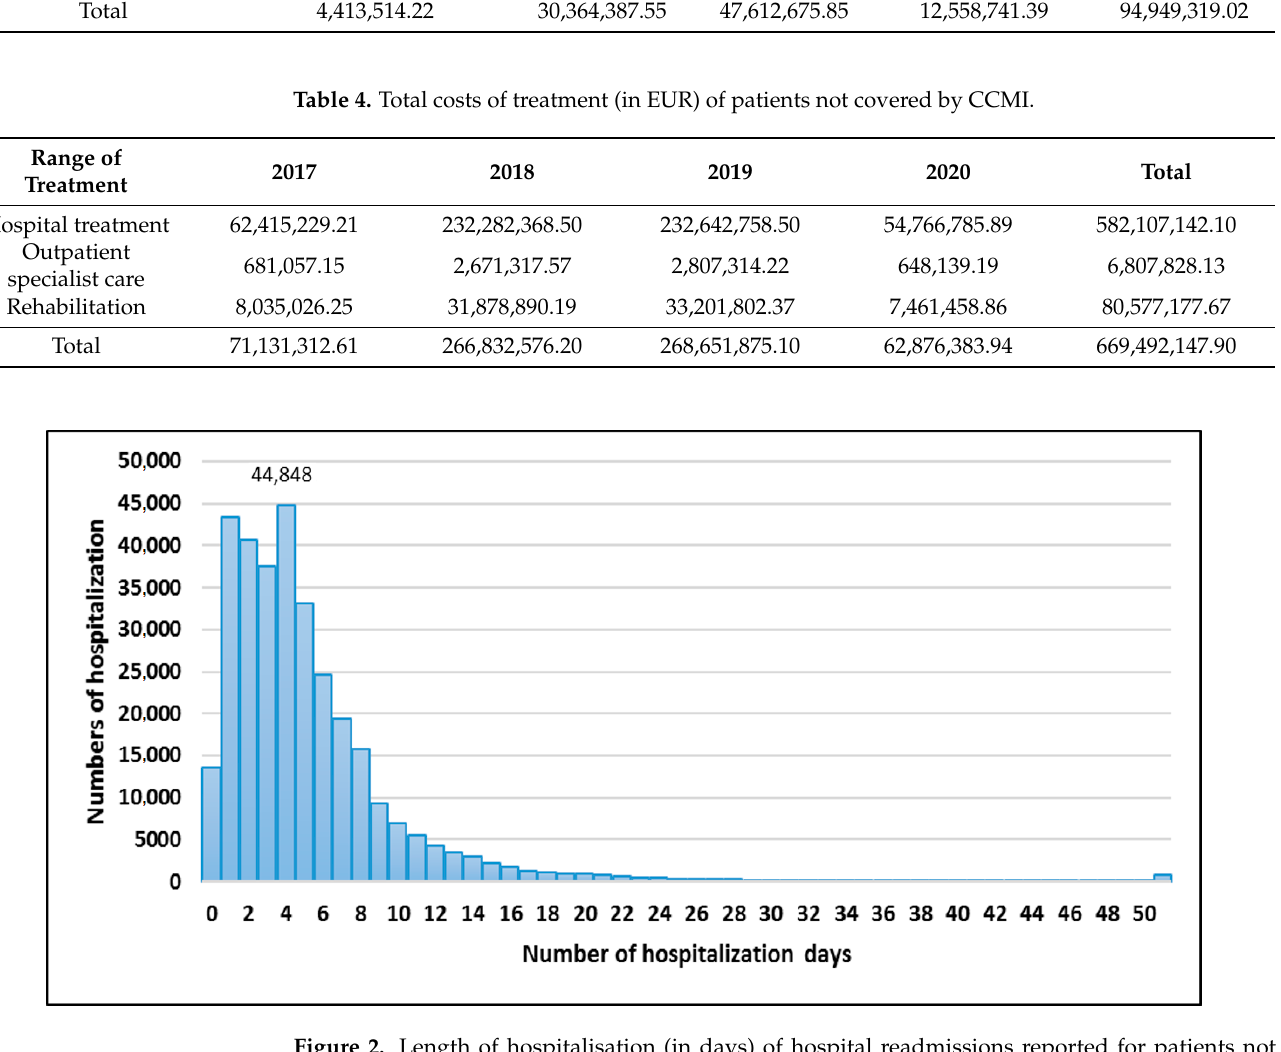
Table 4. Total costs of treatment (in EUR) of patients not covered by CCMI.